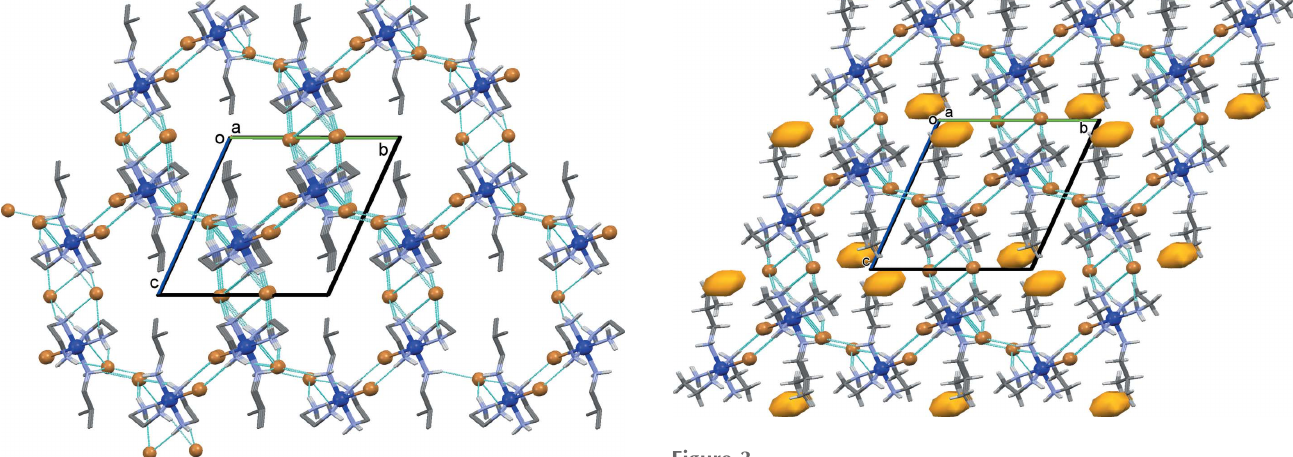
Figure 3 The crystal packing of the title compound, viewed along the a axis, showing the small voids (yellow regions) in the supramolecular frame- work ( Mercury ; Macrae et al. , 2008), and the N—H (cid:3)(cid:3)(cid:3) Br hydrogen bonds (see Table 1) as dashed lines.